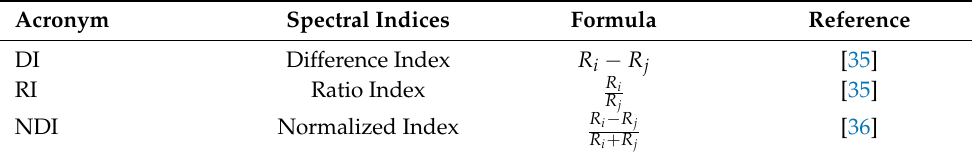
Table 1. Reference overview of the studies on spectral indices and